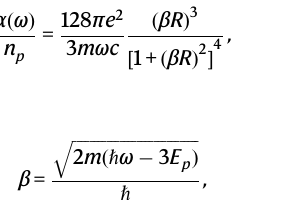
in Eq. (2). Inset: evolution of line shape based on normalized spectra. d Effective polaronstabilizationenergyandsizeevolutionderivedfrom fi tsofspectrainCand polaron absorption in Eq. (2). See main text Eqs. (2) and (3) and associated dis- cussion for the details of these parameters. e Anti-correlation between instanta- neous decay rate constant k and effective stabilization energy E p and size R . f Corresponding anti-correlation between k and Drude scattering time τ D extracted from Drude lineshape fi tting of the data in panel c